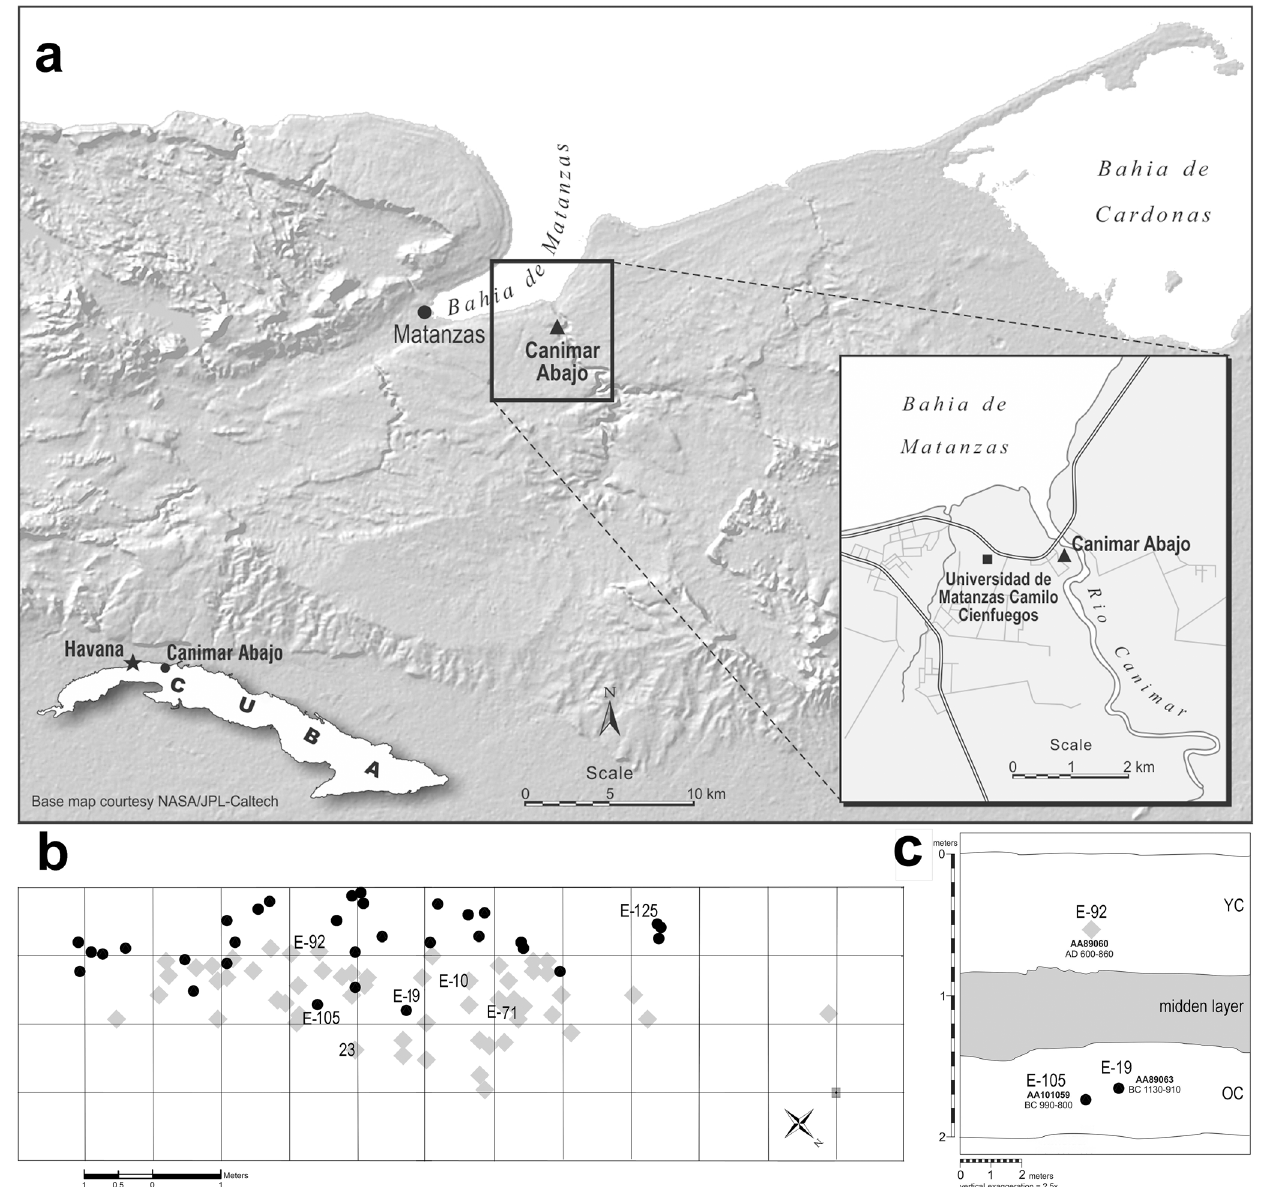
Fig 2. Location of the site of Canímar Abajo and the distribution of burials. The site of Canímar Abajo: a) location of the site at the Bay of Matanzas and on the map of Cuba (outlined in the lower left corner). Reprinted from [18] under a CC BY licence with permission from the University of Arizona, original copyright (2015); and uses the open source satellite map (http://www.jpl.nasa.gov/imagepolicy/); b) horizontal distribution of burials on the excavation grid of the site and the location of individuals discussed in the text: black dots represent Older Cemetery (OC) burials; gray rhombs represent Younger Cemetery (YC) burials; c) schematic representation of the profile of Canímar Abajo with dated burials discussed in the text. Black dots indicate OC burials; gray rhombs indicate YC burials. 14 C laboratory numbers are given with their corresponding